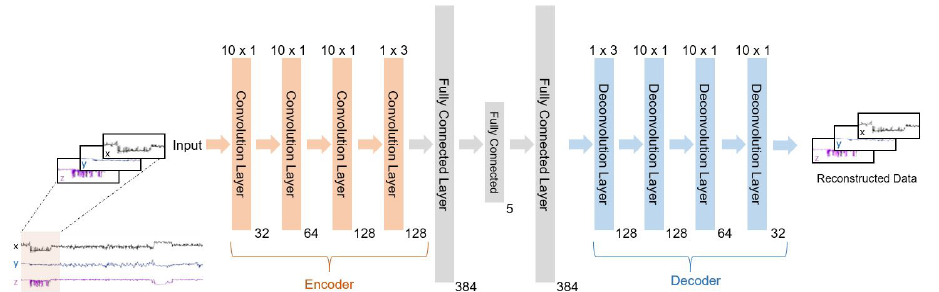
Figure 4. The architecture of the DCAE network for time-series data and detailed configuration in both encoder and decoder parts.